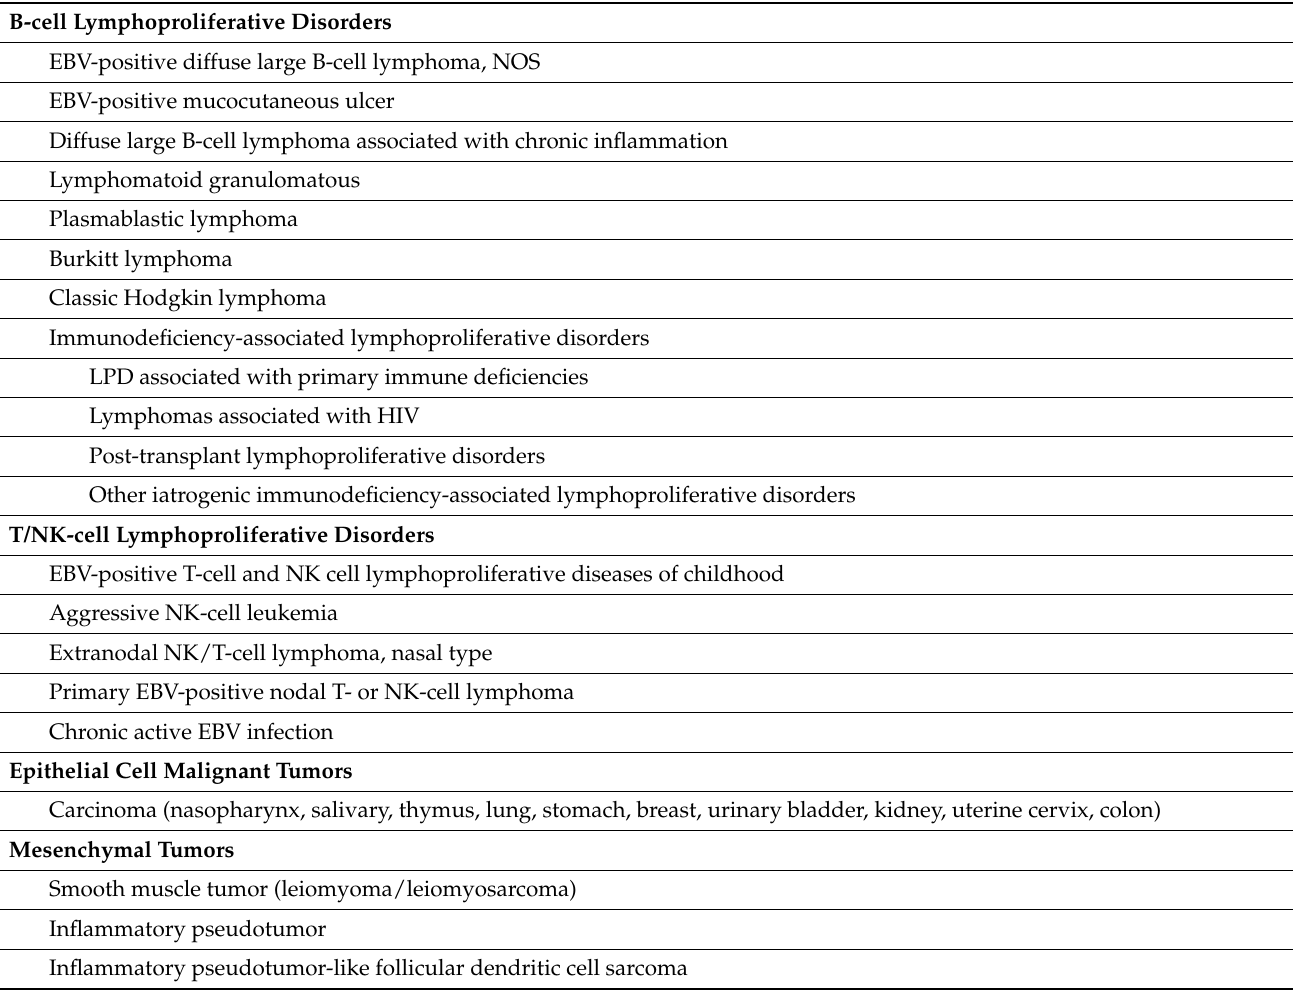
Table 1. EBV-associated